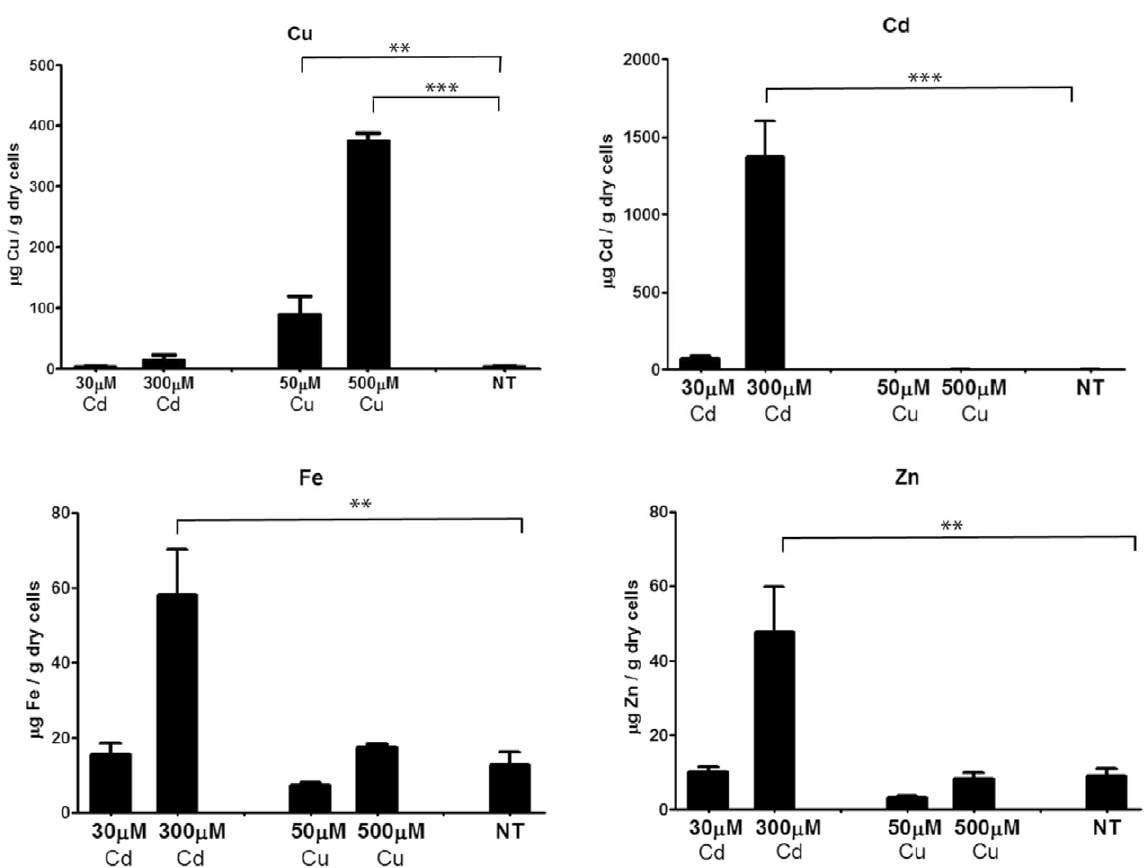
Figure 6. ICP-measured Cd and Cu accumulation in treated lancelets follow different patterns. B. lanceolatum organisms were treated with two different concentrations of Cd or Cu, or non-metal treated (NT). Data is represented as mean and standard deviation of six organisms per group. Statistical significance is represented as ** equivalent to P , 0.01, and *** to P , 0.001 according to the Newman-Keuls statistical test.